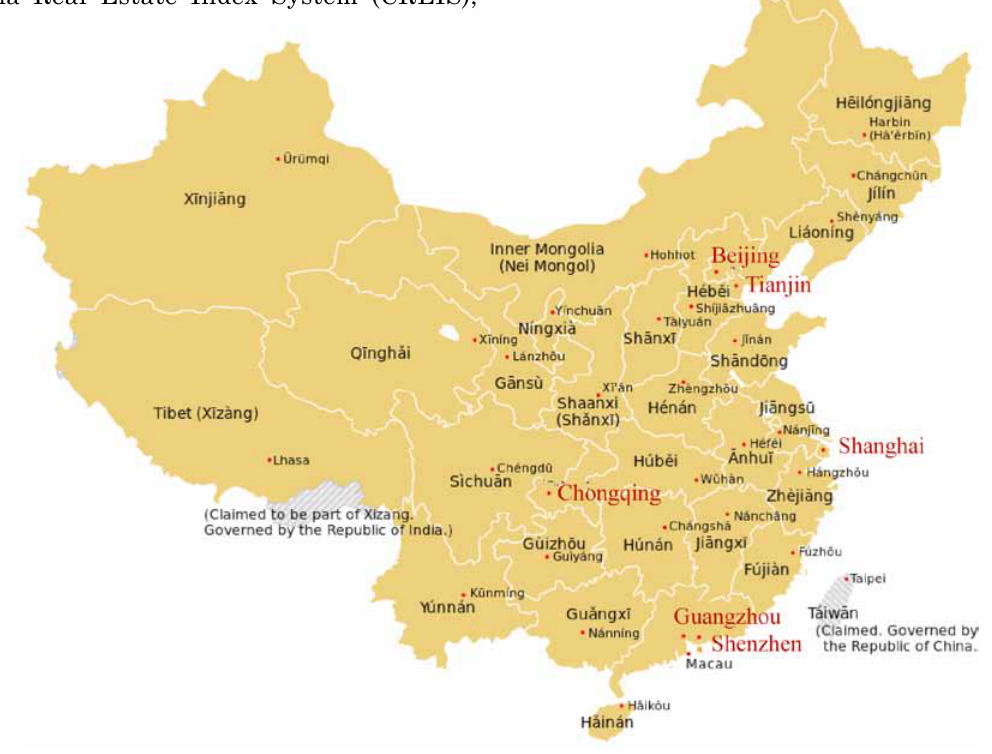
Fig. 1. Provincial map in China ( source: